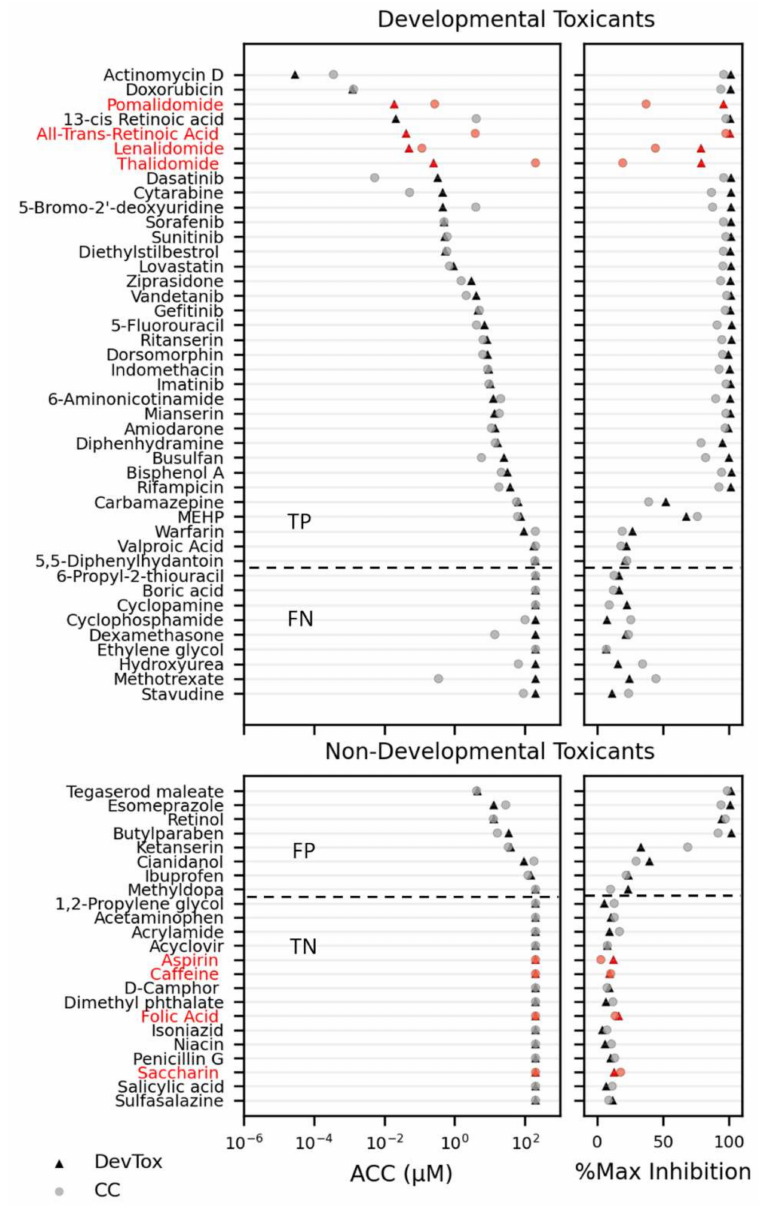
Figure 5. Chemical reference and training set screen results. Developmental toxicants and non- developmental toxicants are ranked by potency (left panels; activity concentration at cutoff (ACC)) with corresponding maximum effect size (right panels; % max inhibition) for percent SOX17-positive cell (DevTox—triangle) and cell count (CC—circle). Reference chemicals are indicated in red. The horizontal dashed line indicates separation of chemicals identified as positive (top) or negative (bottom) hit calls in the RUES2 GLR-Endo assay. (TP—true positive; FP—false positive; TN—true negative; FN—false